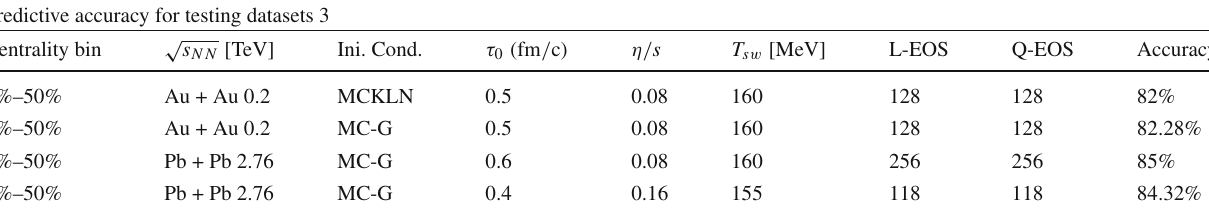
Table 9 Predictive accuracy on testing datasets 3: cascade-coarse-grained spectra ρ c ( p T ,(cid:6)) generated with the different η/ s , τ 0 , and T s w in the centrality range 0–50% Predictive accuracy for testing datasets 3